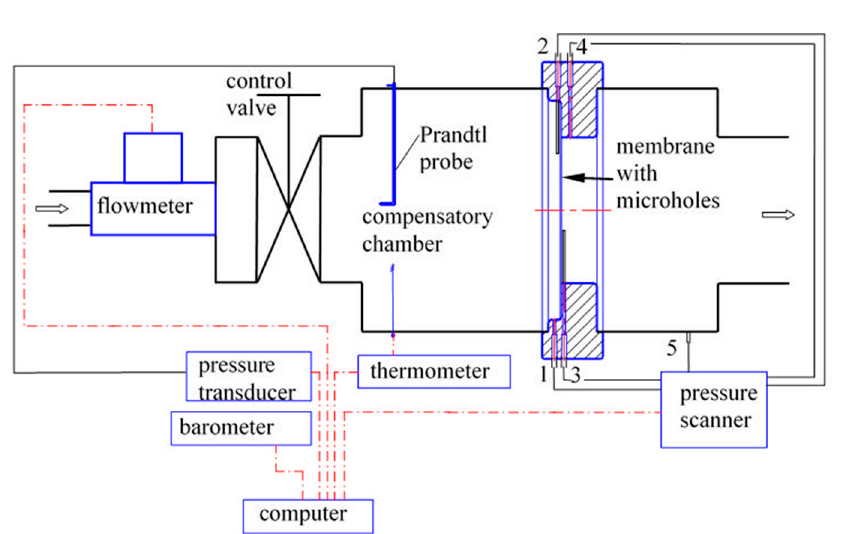
Figure 2. Arrangement of the measurement system.